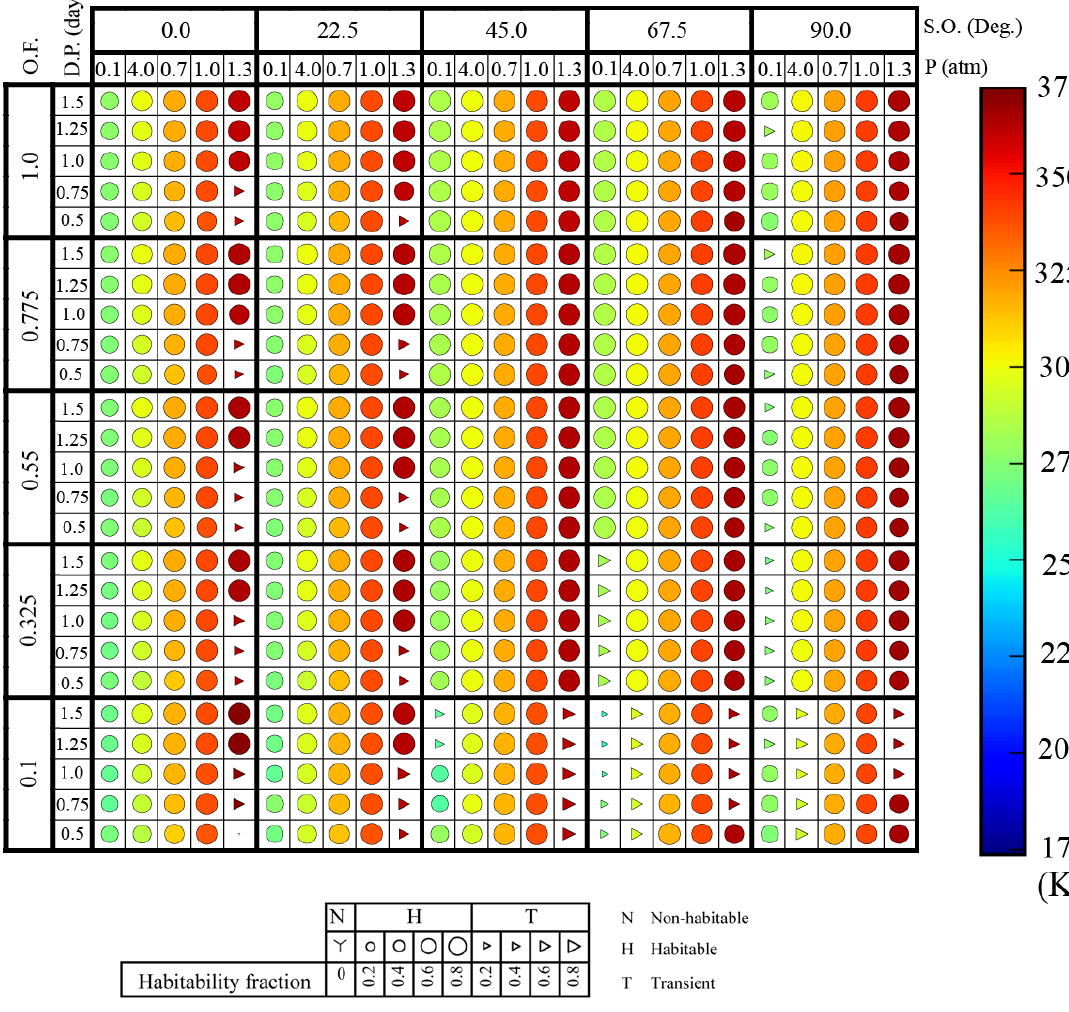
Figure 5. τ Ceti e parameters map - All parameters are in an increasing order from left to right and bottom to up. Pressures are (0.1, 0.4, 0.7, 1, 1.3) atm, Diurnal Periods are (0.5, 0.75, 1.0, 1.25, 1.5) days, Spin Obliquities are (0.0, 22.5, 45.0, 67.5, 90.0) degrees, and Ocean Fractions are (0.1, 0.325, 0.55, 0.775, 1.0). They are displayed in the map,